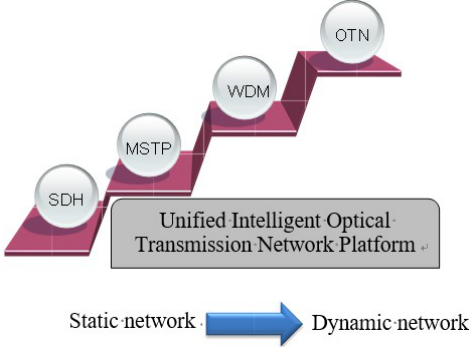
Figure 1. Relationship between SDH, OTN and ASON